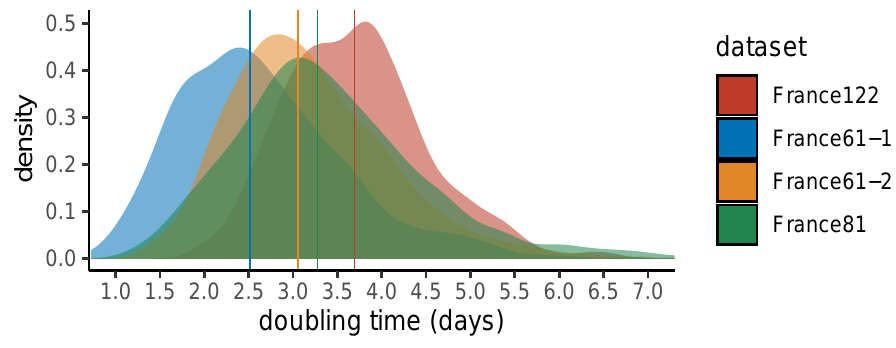
Figure 3 – Epidemic doubling time. We assume an exponential growth coalescent model with a fixed molecular clock. The four datasets differ in the sequences analysed (see the Methods). Vertical lines show the distribution